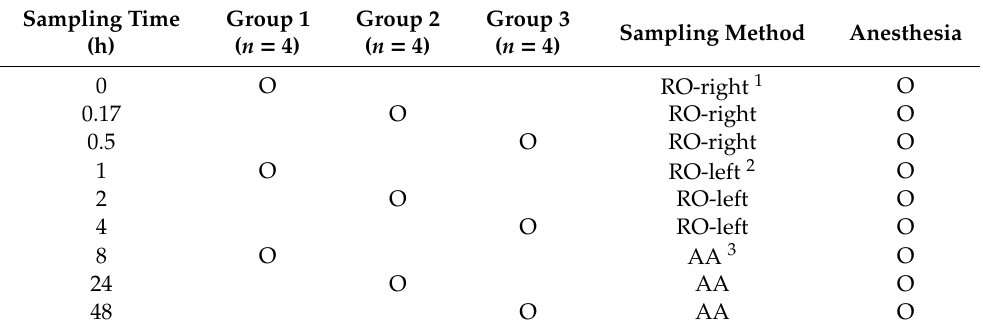
Table 2. Blood sampling schedule for the pharmacokinetic study of compound K in mice and rats following intravenous injection of compound